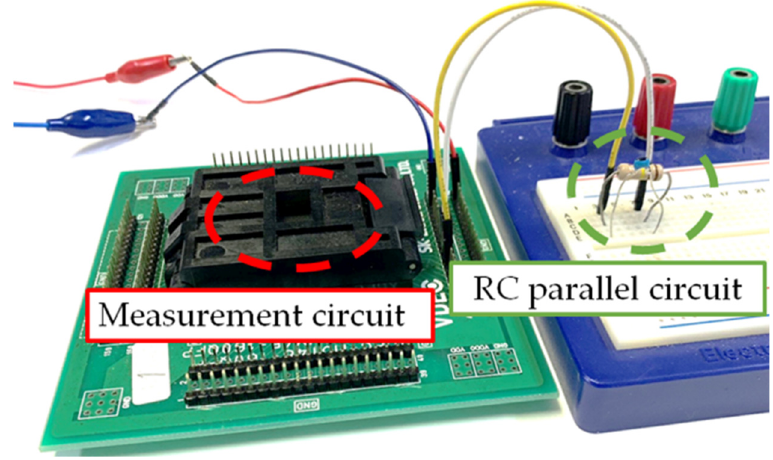
Figure 12. Measuring an RC parallel circuit using a measurement circuit.